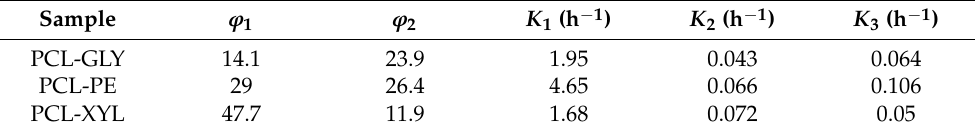
Table 3. Equation (3) fitting parameters for the drug-polymer dissolution